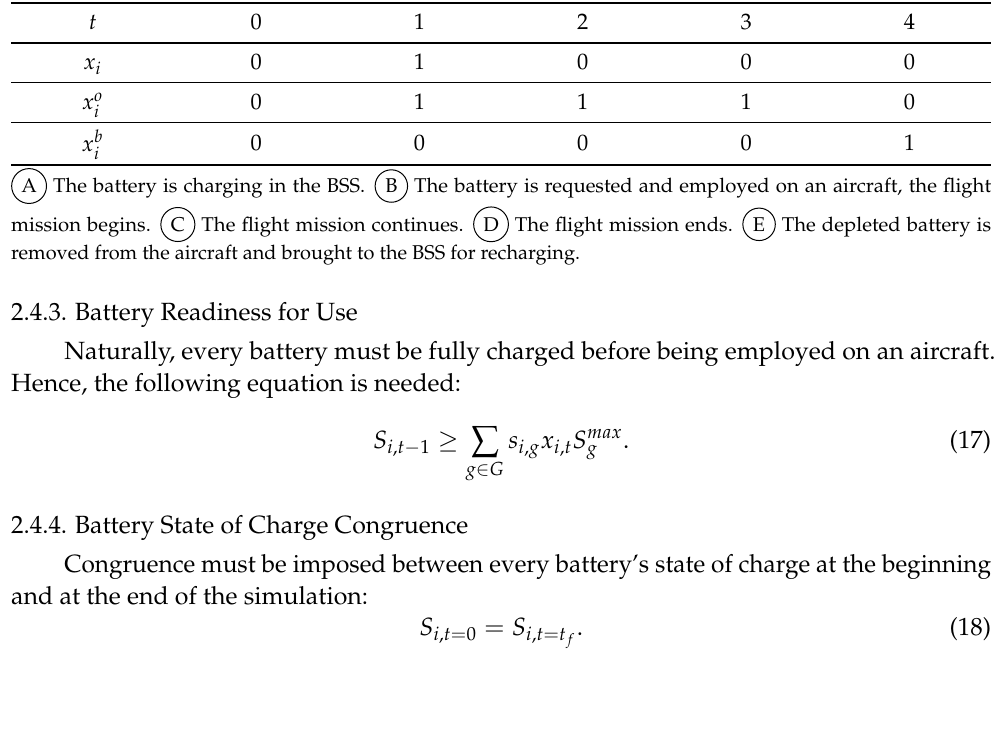
, x b and x i , t . i , t i , t